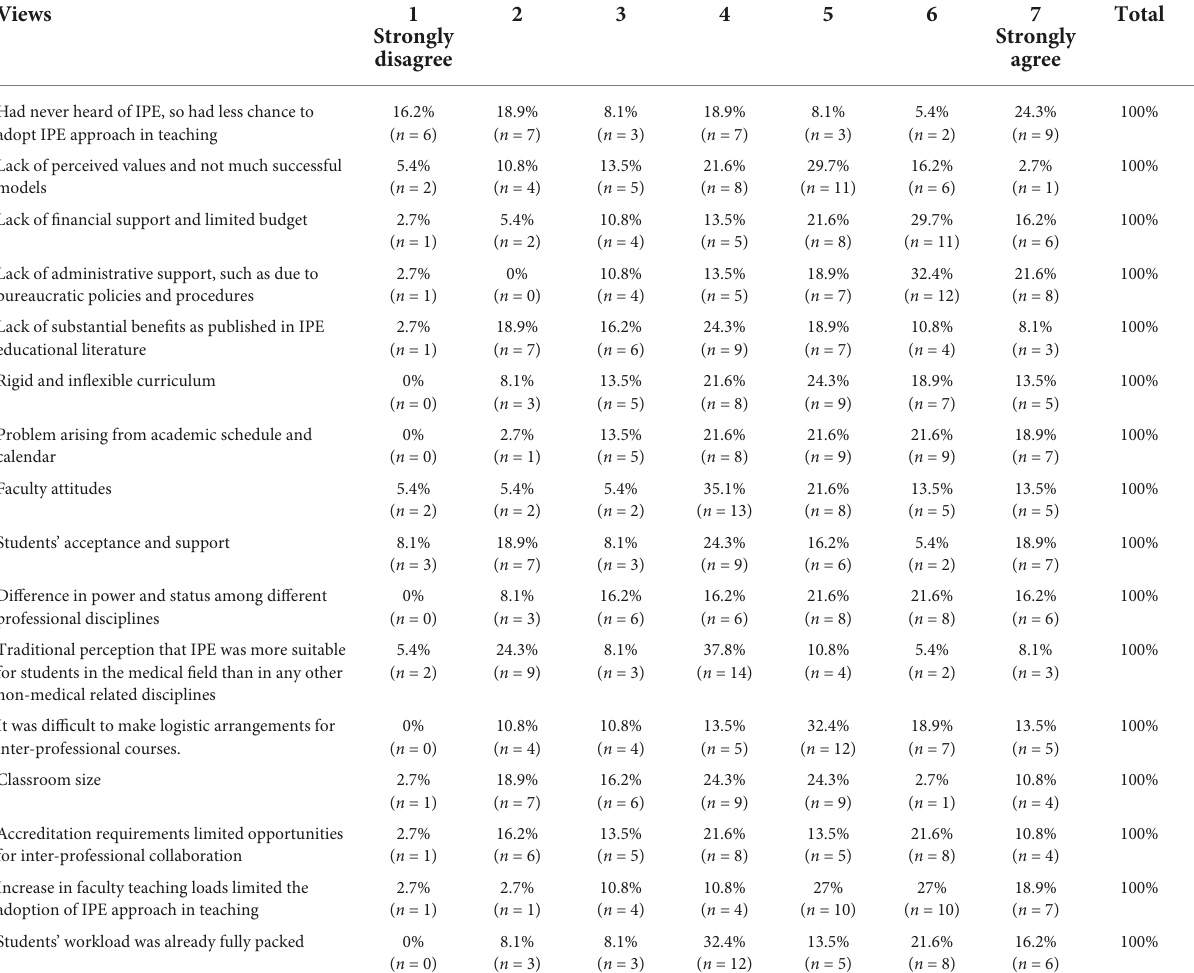
TABLE 3 Barriers to interprofessional education